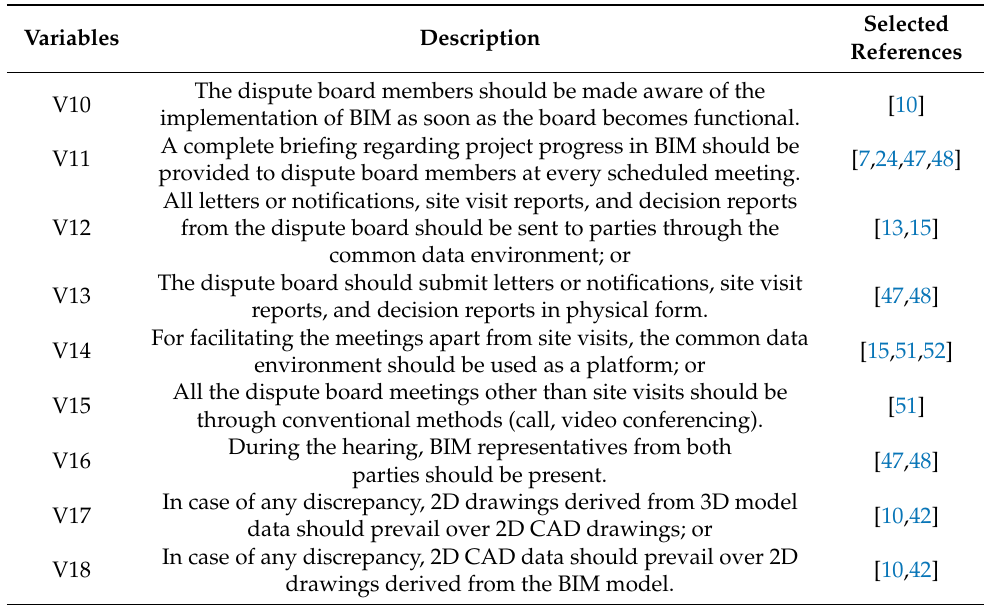
Table 2. Potential legal aspects/contract provisions for procedural rules of dispute board. Variables